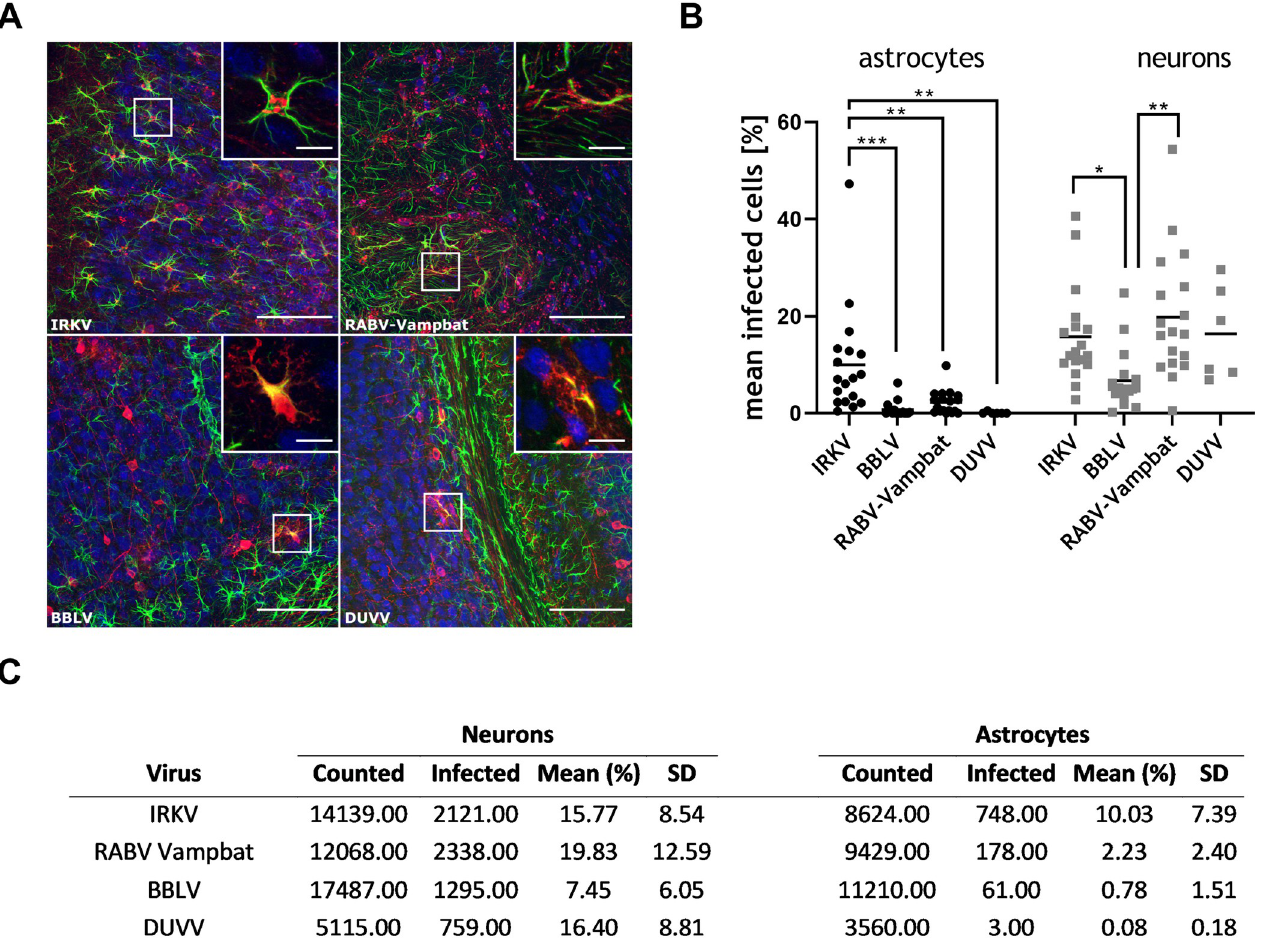
Fig 7. Comparison of the astrocyte tropism of different bat lyssaviruses with a high and low IMPI. A) Indirect immunofluorescence of solvent-cleared brain sections demonstrates the presence of lyssavirus phosphoprotein P (red), neurons (blue, marker: NeuN) and astrocytes (green, marker: glial fibrillary acidic protein, GFAP). Insets show RABV P accumulation (red) at GFAP-positive cells (green). x, y = 387.5 μ m, 387.5 μ m; z = 65.5 μ m (IRKV), 36.5 μ m (RABV-Vampbat), 64.5 μ m (BBLV), 65.5 μ m (DUVV). Scale bar = 100 μ m (overview), 15 μ m (inset). B) Percentage of infected astrocytes (black dots) and neurons (gray squares). Per virus, 3 to 11 × 10 3 astrocytes and 5 to 17 × 10 3 neurons were counted in independent confocal z-stacks in two animals per isolate (one animal for DUVV). Each dot represents the ratio of infected astrocytes or neurons in an analyzed z-stack. Mean values are provided as horizontal lines. Statistical comparisons of the means between the different groups are indicated for those with a statistically significant difference ( � p � . 05 ; �� p � . 01 ; ��� p � . 001 ; ordinary one-way ANOVA with Tukey’s multiple comparison test). C) Corresponding data table for the measurements. RABV-Raccoon (33%) and RABV-Vampbat (33%) (Fig 8A). Independent of the route of infec- tion, 97% of diseased mice inoculated with RABV strains were positive for viral RNA in sali- vary glands, and in 72% of mice viral RNA was also detected in the corresponding oral swabs (Fig 8B). In contrast, mice infected with non-RABV bat lyssaviruses exhibited significantly lower positivity rates (p < 0.0001, Fischer’s exact test), i.e. in only 50% of the diseased animals, salivary glands were positive for viral RNA, and 12% exhibited both virus RNA-positive sali- vary glands and oral swabs (Fig 8B). Regarding the presence of infectious virus, a similar pat- tern was observed when all routes of infection were considered (Fig 8C and 8D). When grouped together, infectious virus could be isolated in 86% of salivary gland samples from mice that succumbed to RABV, while infectious virus shedding, as determined by virus isola- tion from both salivary glands and oral swabs, was 47% overall, with the highest proportion in